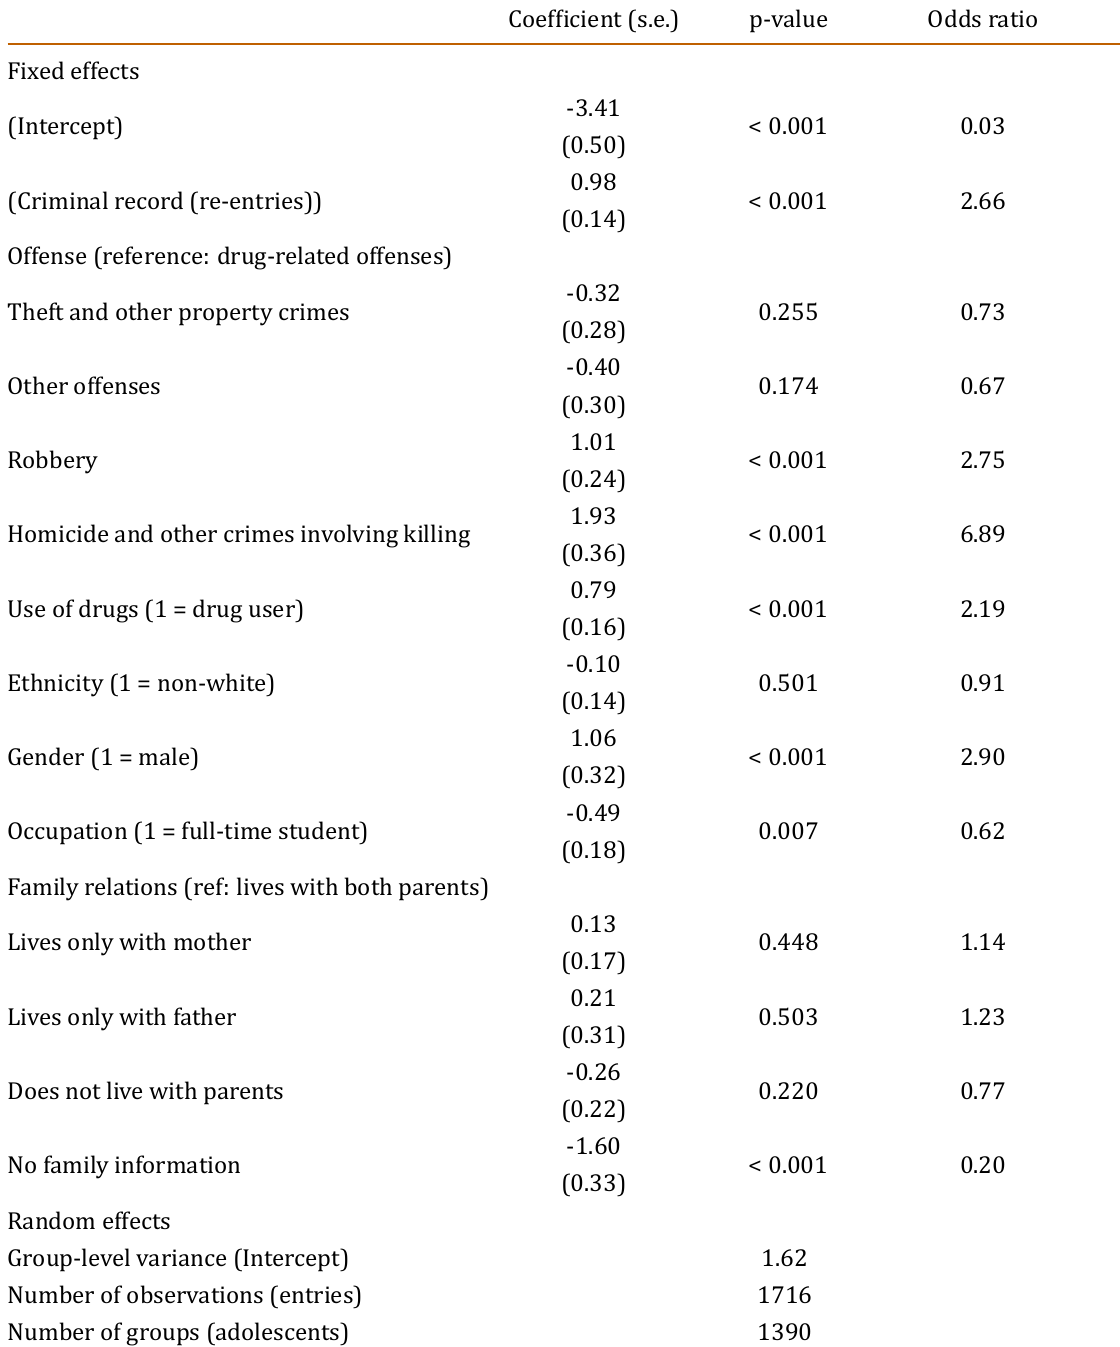
Table 2: Impact of legal and extralegal attributes on